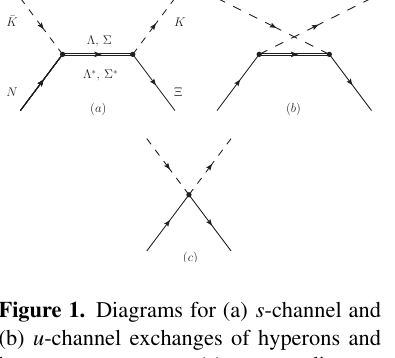
Figure 1. Diagrams for (a) s -channel and (b) u -channel exchanges of hyperons and hyperon resonances; (c) contact diagram (see Eq.